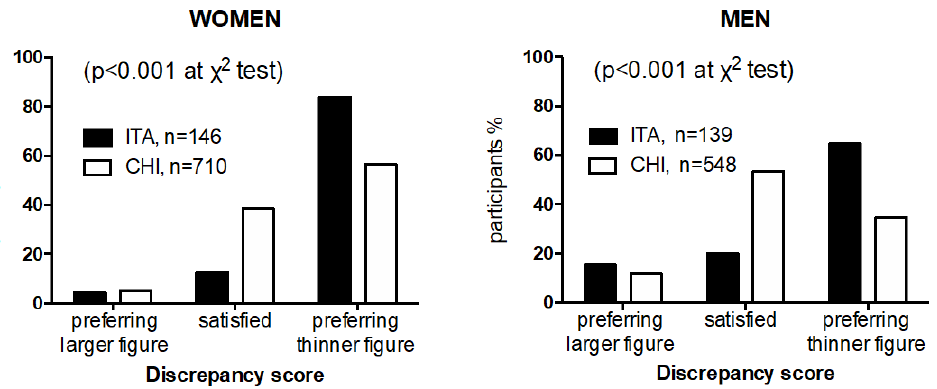
Figure 1. Distribution of discrepancy score categories (negative value, 0, positive value) in Chinese migrants and native Italians by gender.